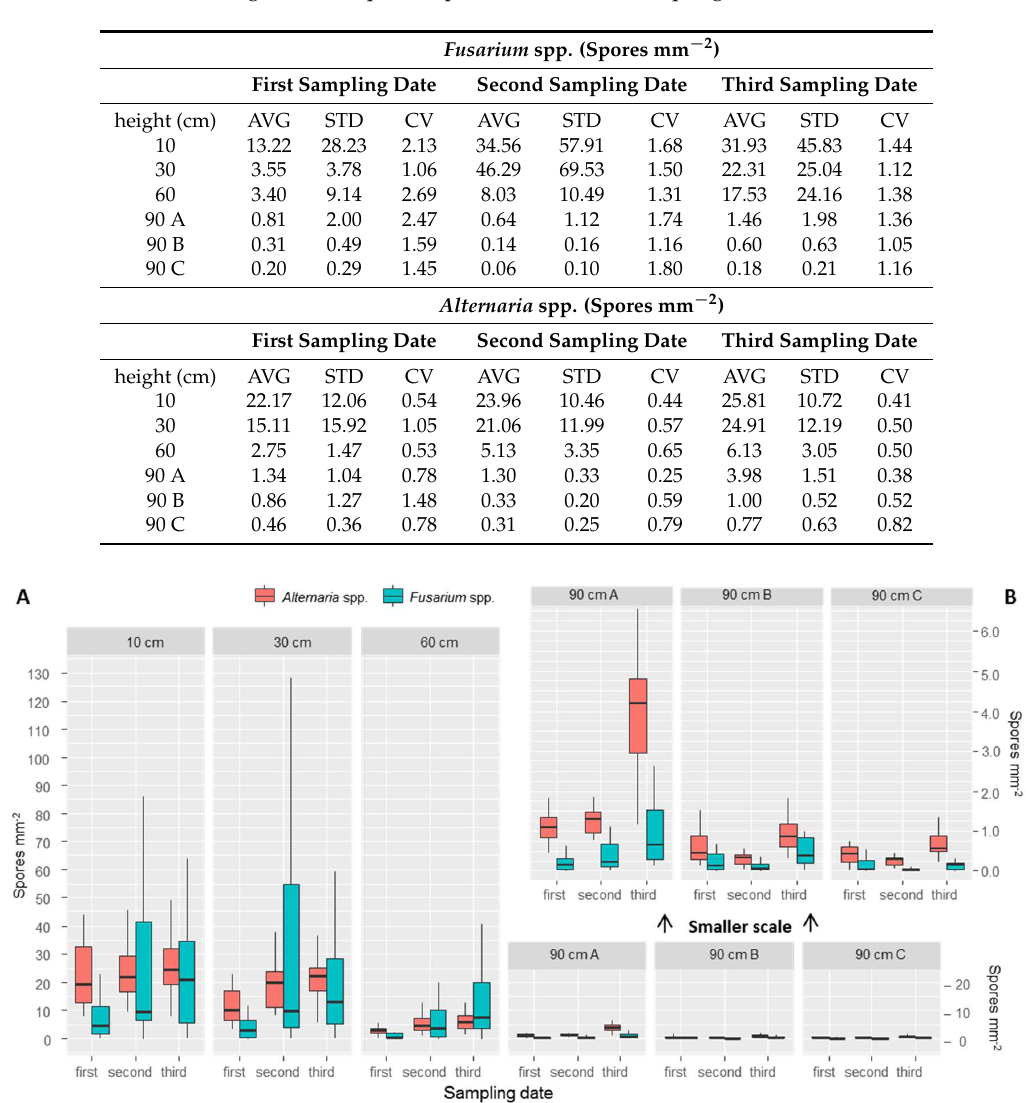
Table 2. Average number of spores (AVG), standard deviation (STD) and coefficient of variation (CV) counted at different heights of the spore traps and at different sampling dates.